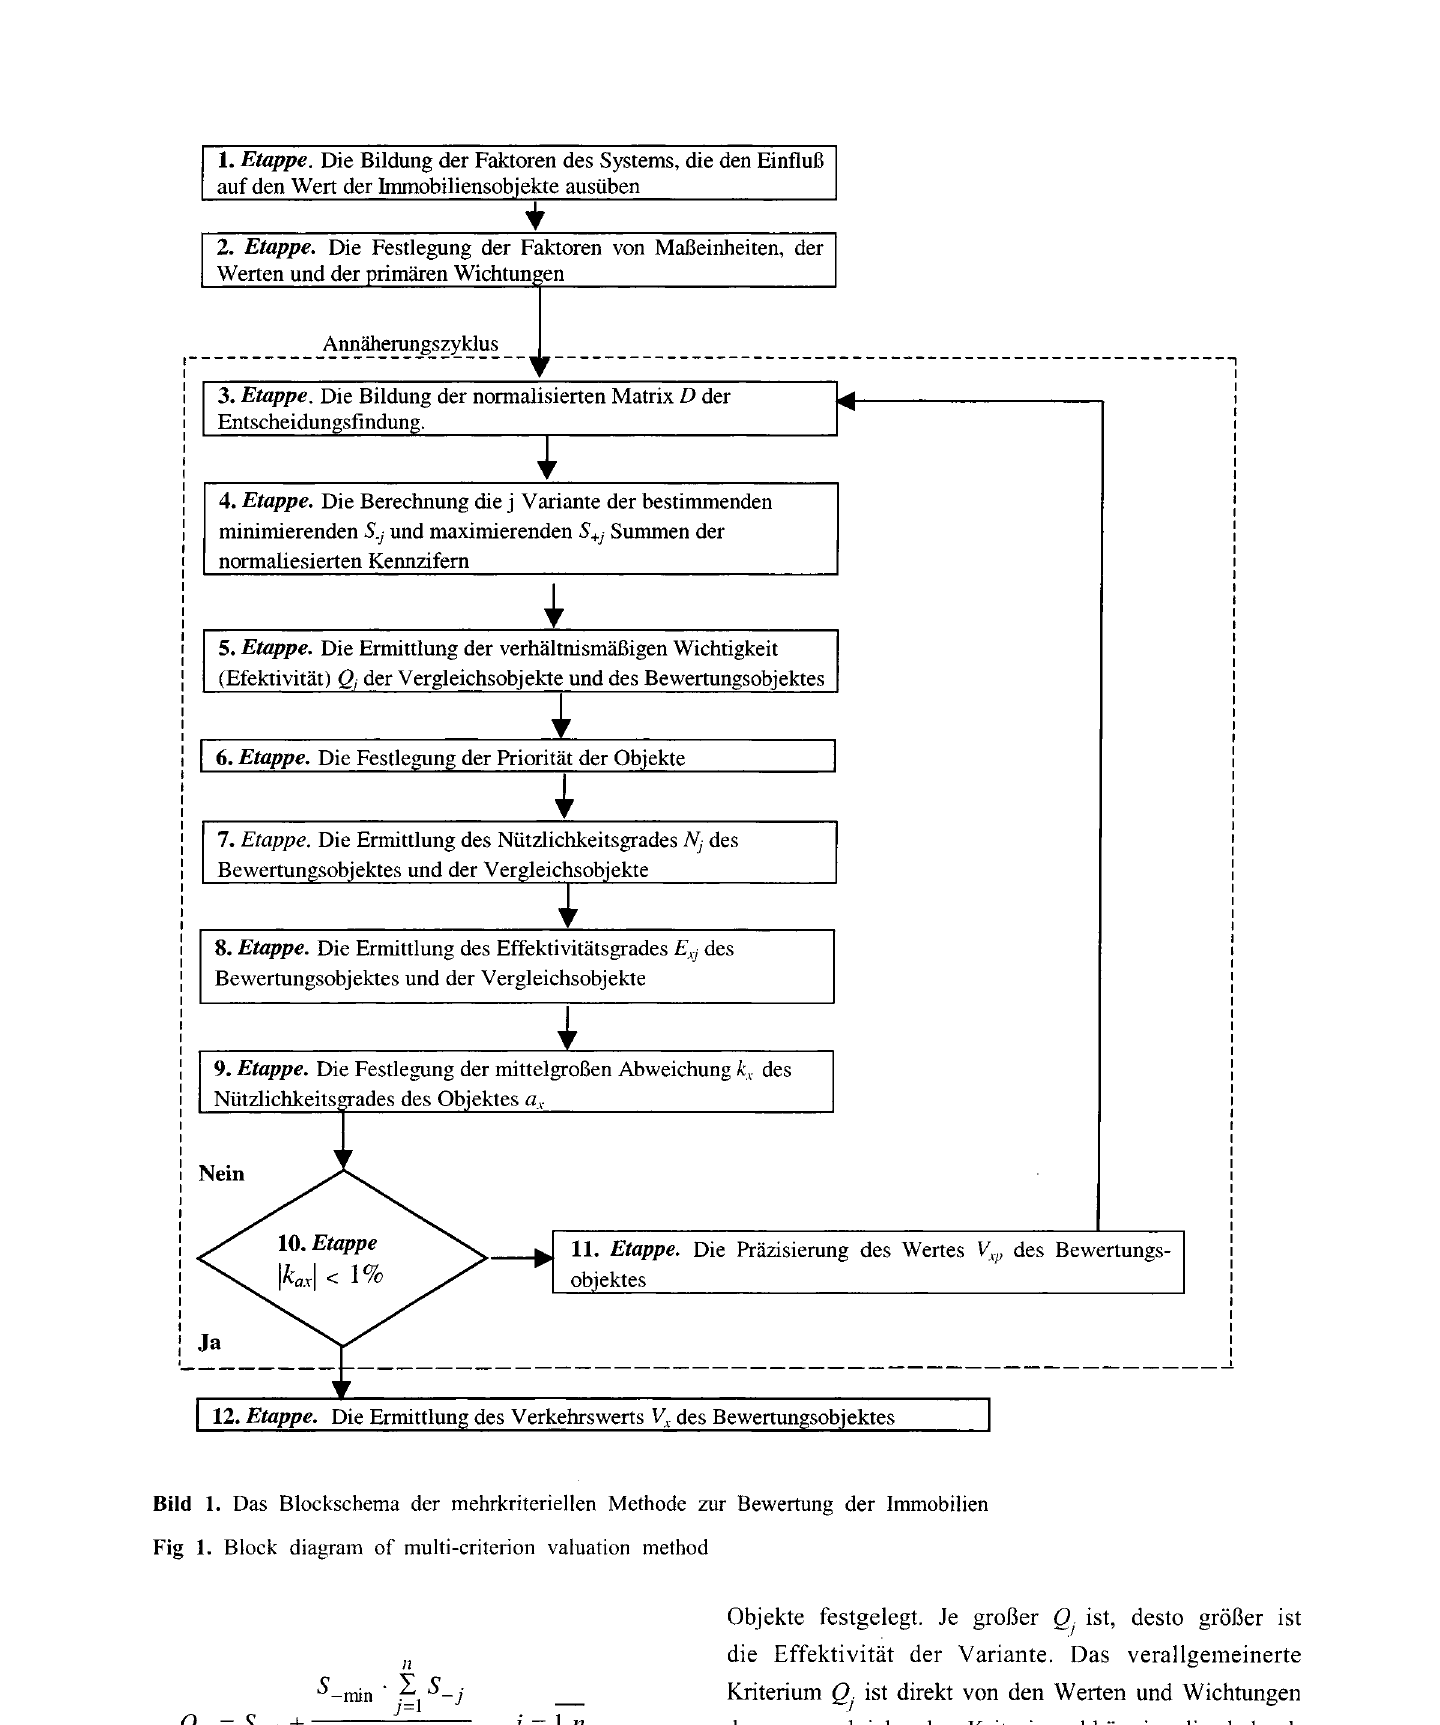
Fig 1. Block diagram of multi-criterion valuation